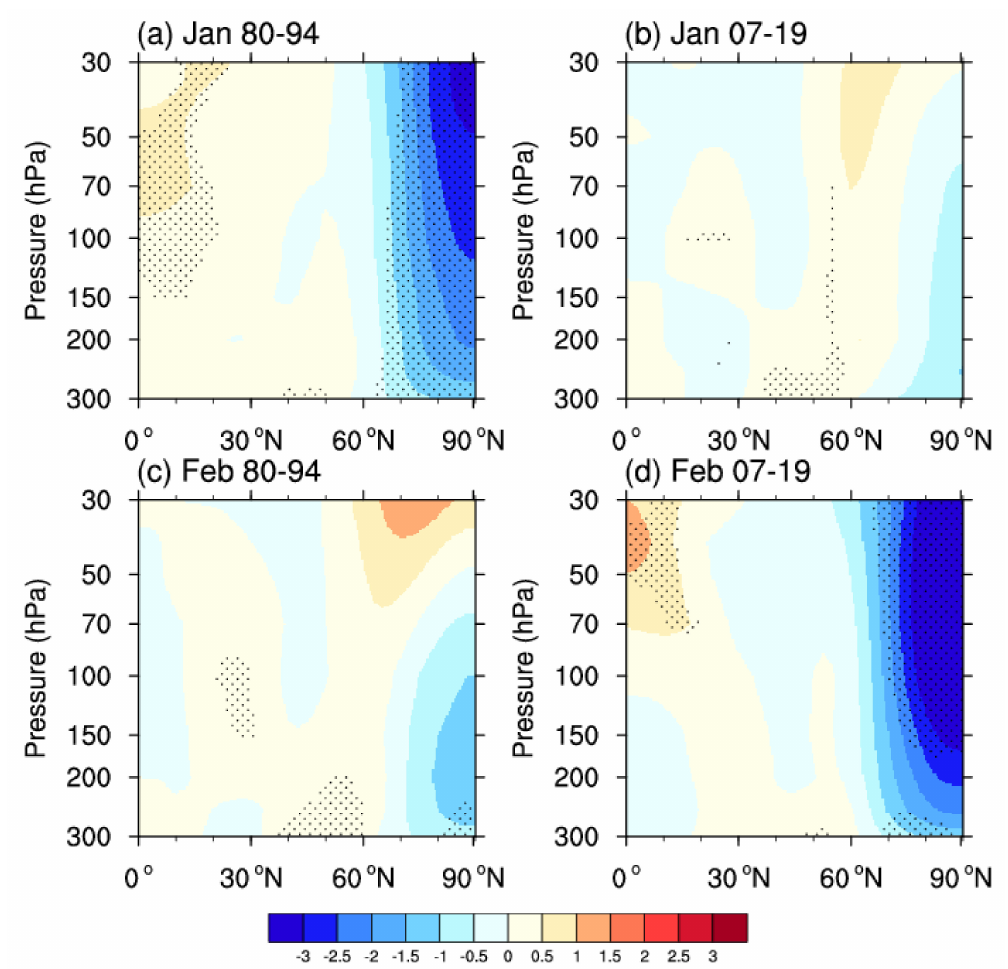
Figure 11. Regression of the zonal mean temperature (K) based on the AO index in ( a , b ) January and ( c , d ) February during ( a , c ) 1980–1994 and ( b , d ) 2007–2019. The values over the stippled regions are statistically significant at the 95% confidence